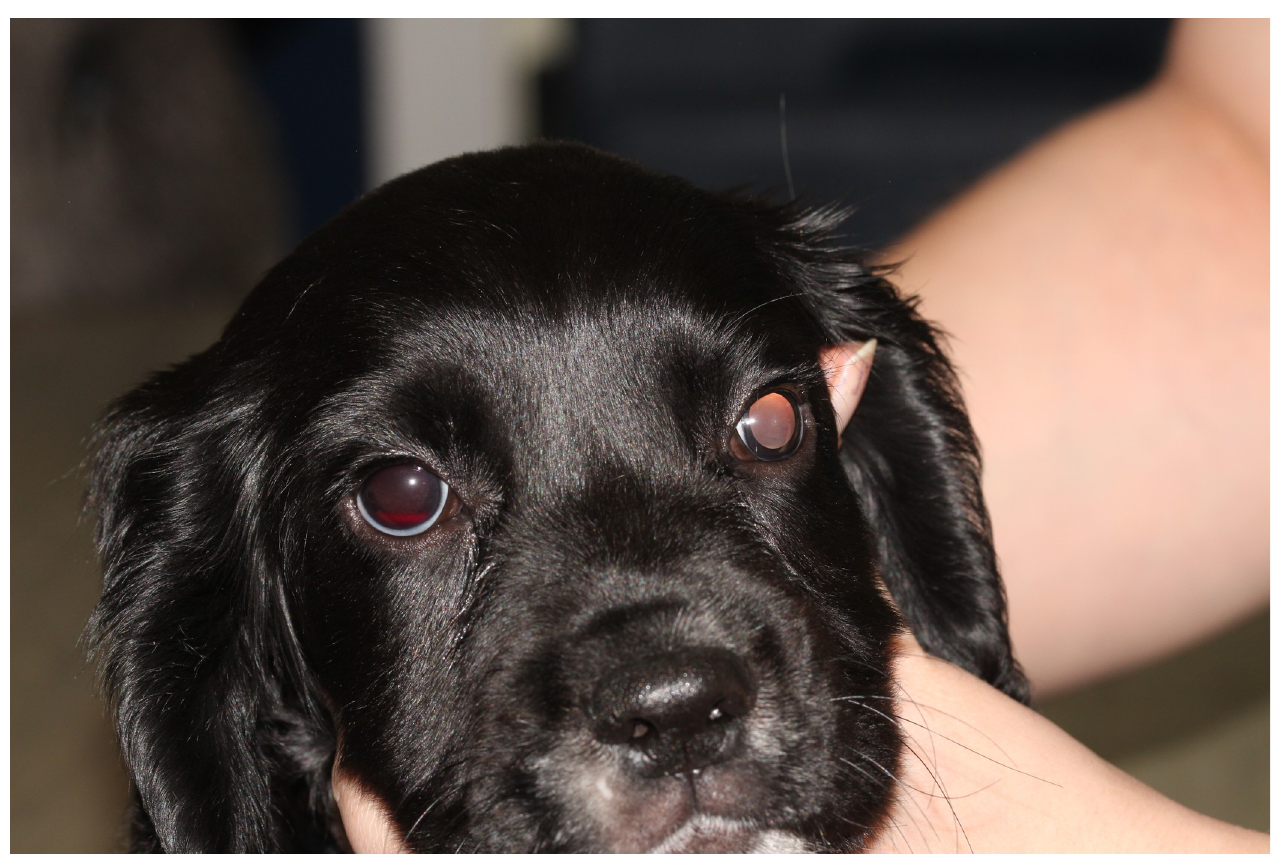
Fig 2. Ocular defects associated with affected ECS. Showing RD-affected male with hyphema of the right eye.